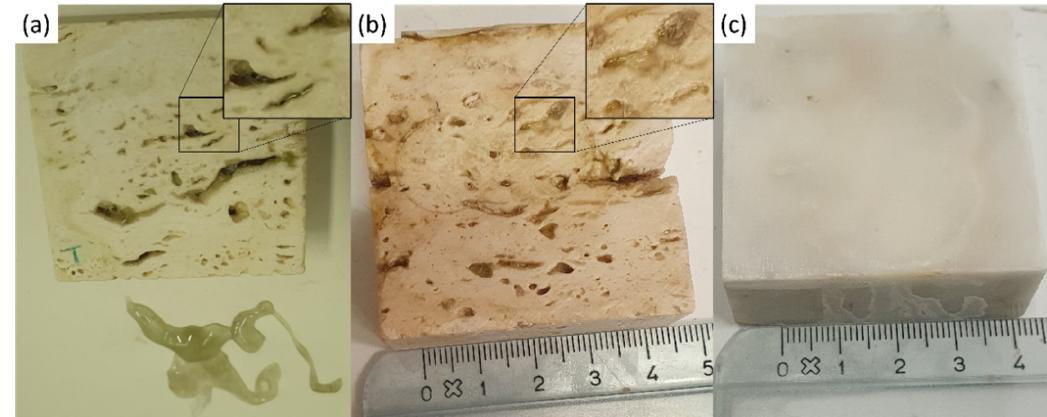
Figure 11. Stone surfaces after PVA-PEO-borax hydrogel cleaning of ( a ) Travertine 1 soiled with corrosion products from penny, ( b ) Travertine 2 soiled with corrosion products from euro cents, and ( c ) Carrara marble soiled with corrosion products from euro cents. In the zoomed portions transparent gel residues are observable in the pores.